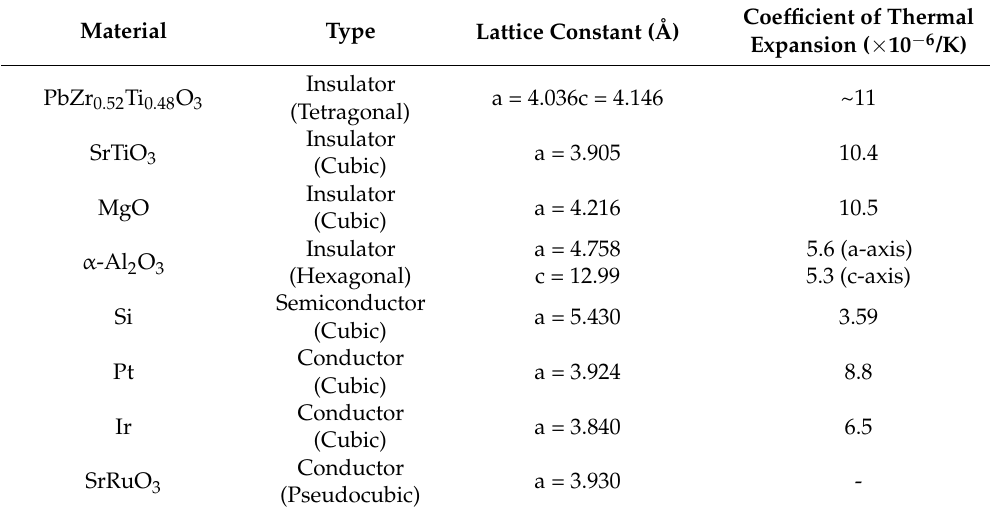
Table 3. Comparison of materials and their properties for substrate and bottom electrode. Reprinted with permission from [26] Taylor & Francis